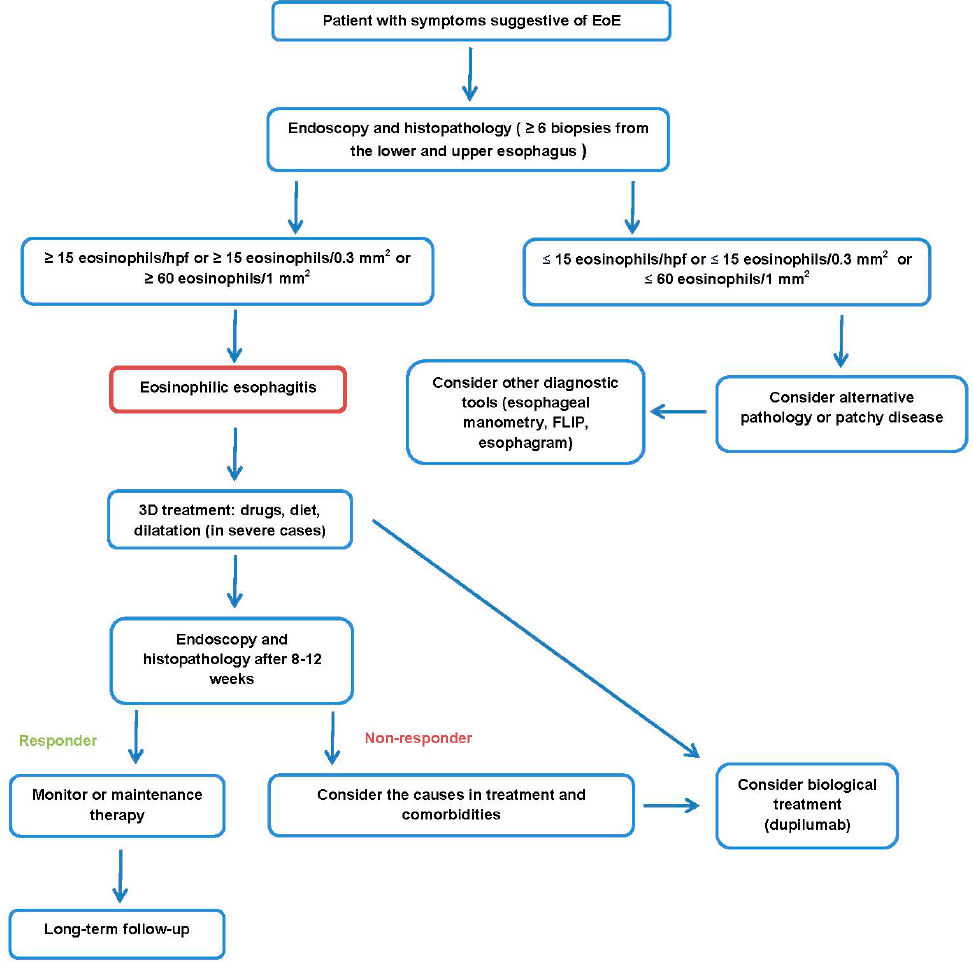
Figure 1. Proposal of EoE management.